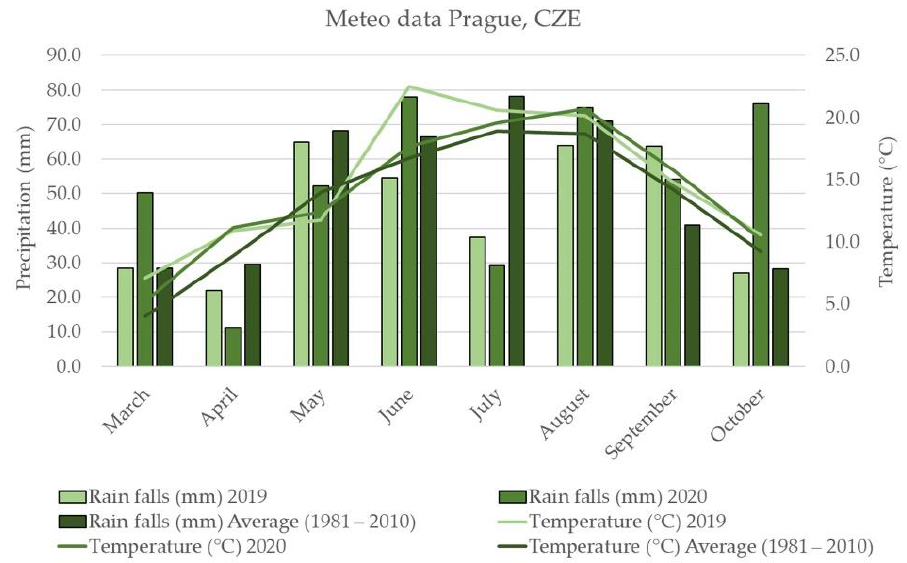
Figure 6. Weather conditions in the Czech Republic in 2019 and 2020 in comparison with the long-term average (1981 – 2010).